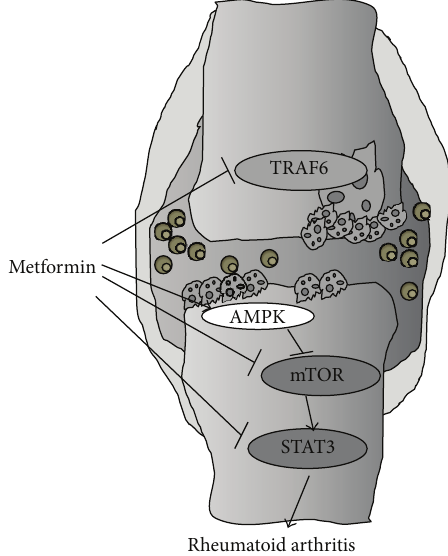
Figure 6: The signaling pathway that metformin uses to regulate T cell and osteoclasts in autoimmune